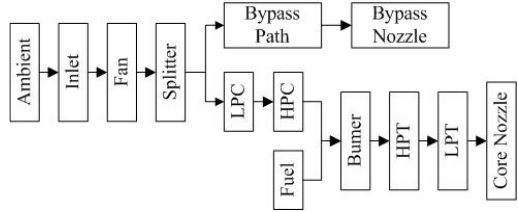
Figure 2. Layout of various modules and their connections